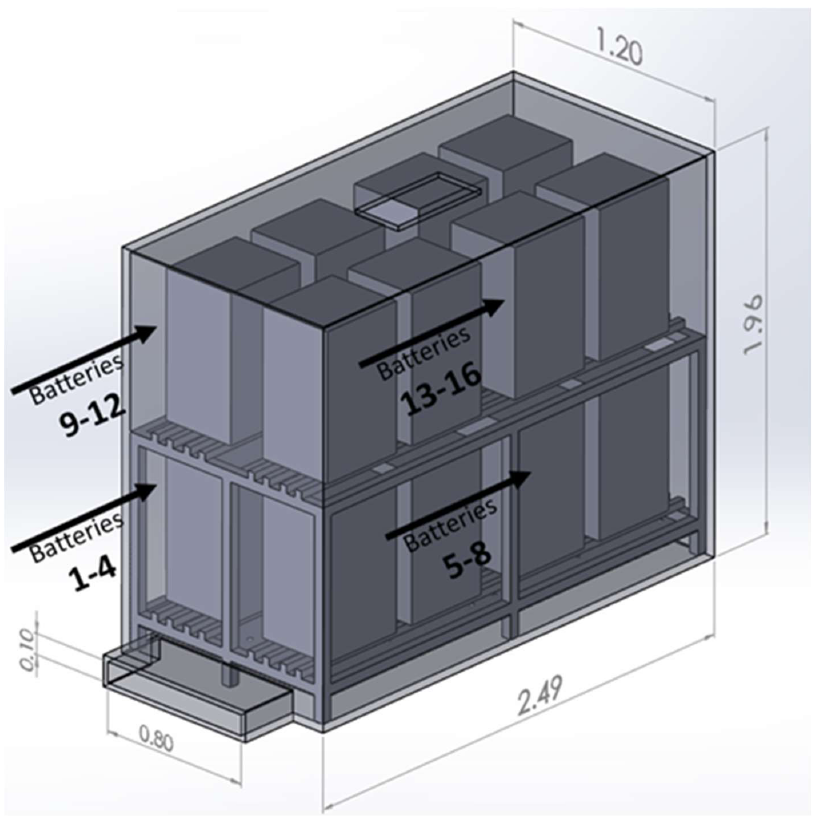
Figure 2. Full-scale default design model. All dimensions shown are in meters. Batteries grouping emulates the configurations typical of a stationary battery system.